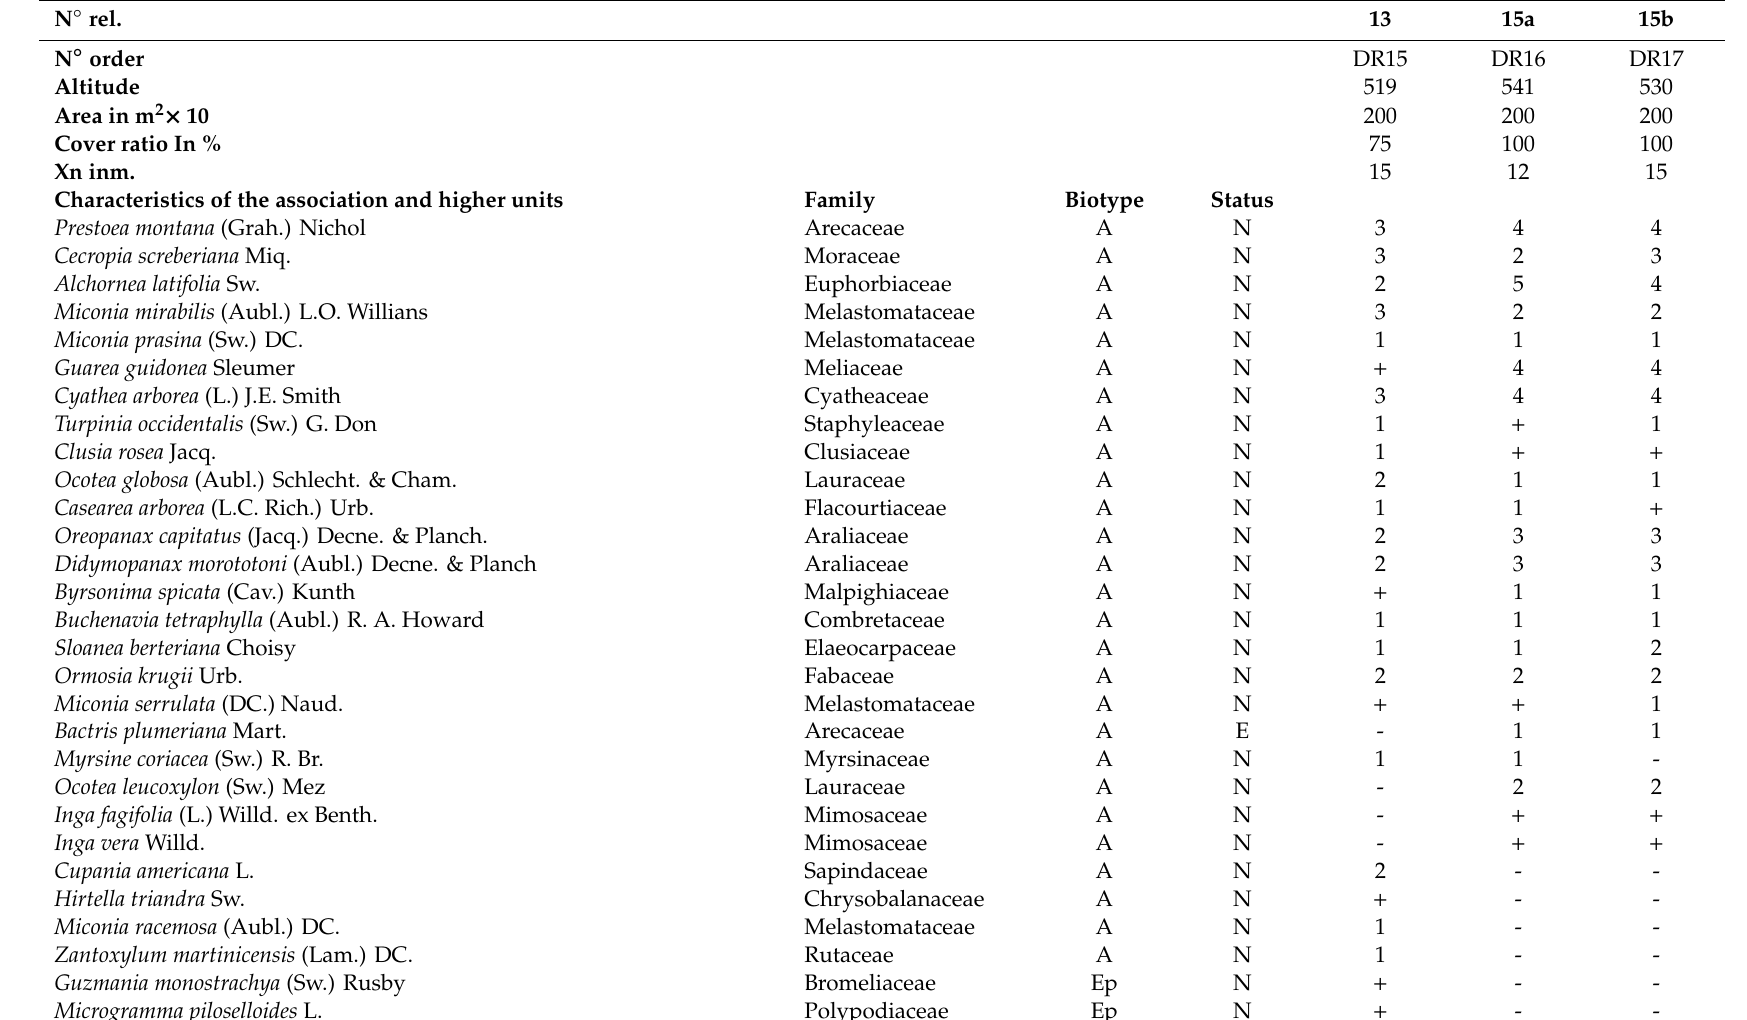
Table A4. Association Ormosio krugii-Prestoetum montanae